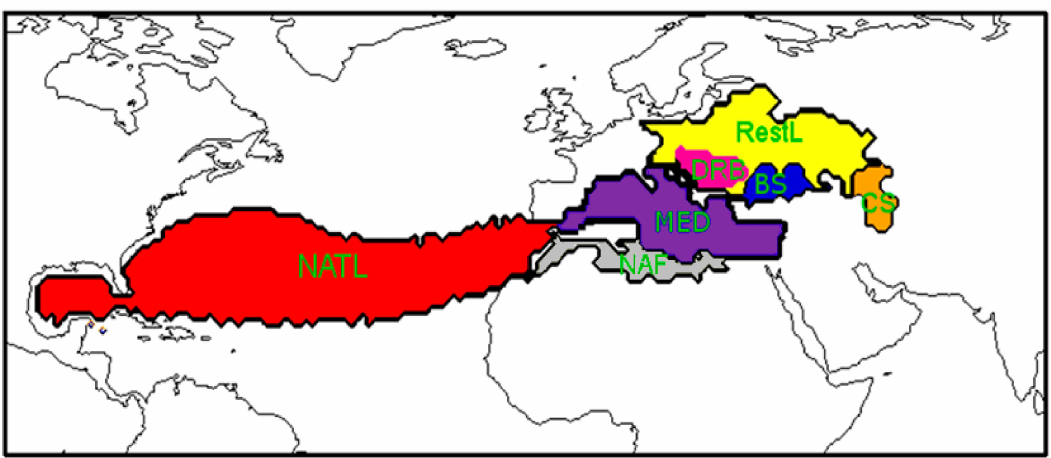
Figure 2. Moisture sources (Evaporation minus Precipitation) (E − P) for the Danube River Basin according to the Ciric et al. [7]. The black contour line indicates the sources: NATL (North Atlantic Ocean) red color, MED (Mediterranean Sea) violet color, NAF (North Africa) grey color, DRB (Danube River Basin) pink color, BS (Black Sea) blue color, CS (Caspian Sea) orange color, and Rest of Land RestL (Central and Eastern Europe) yellow